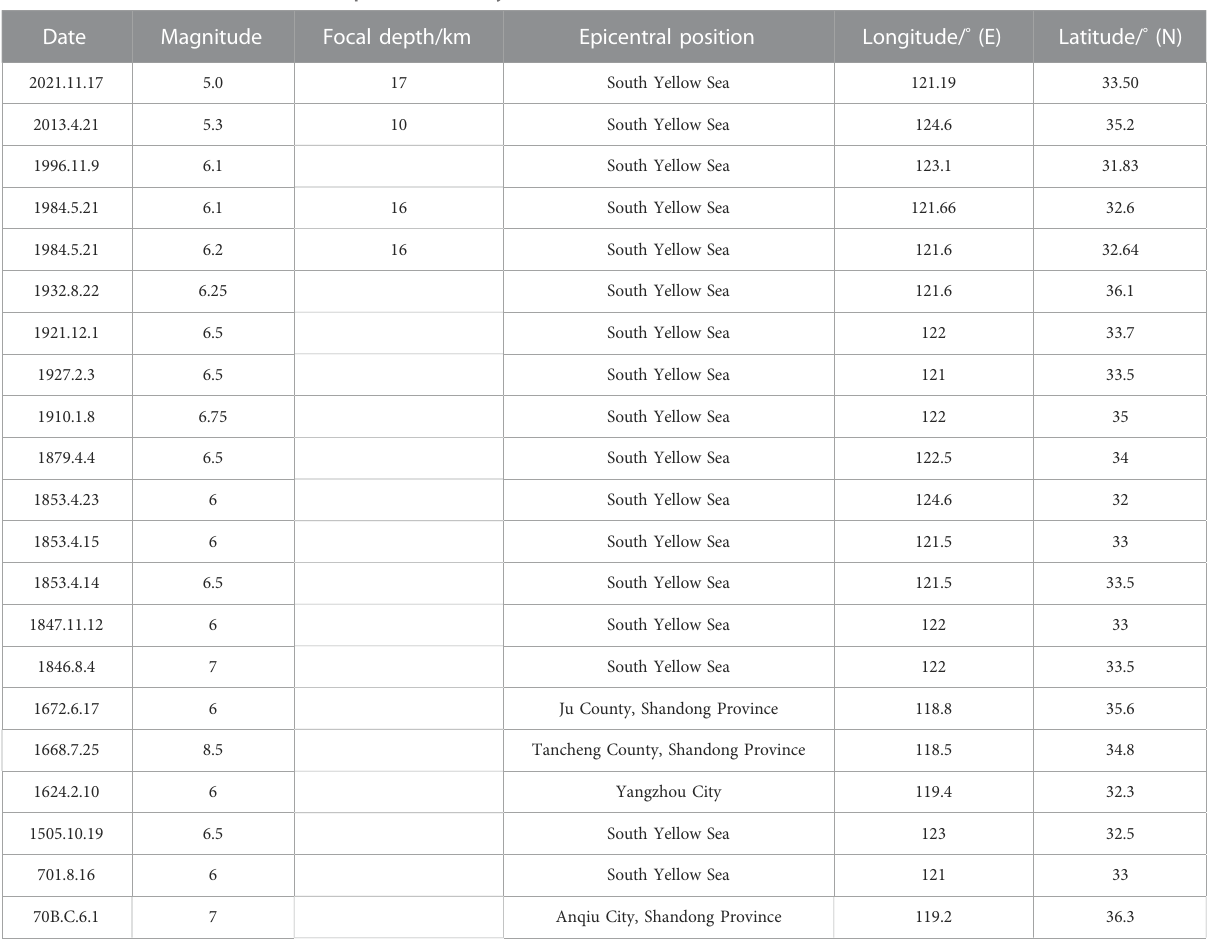
TABLE 1 List of historical and modern earthquakes in the study